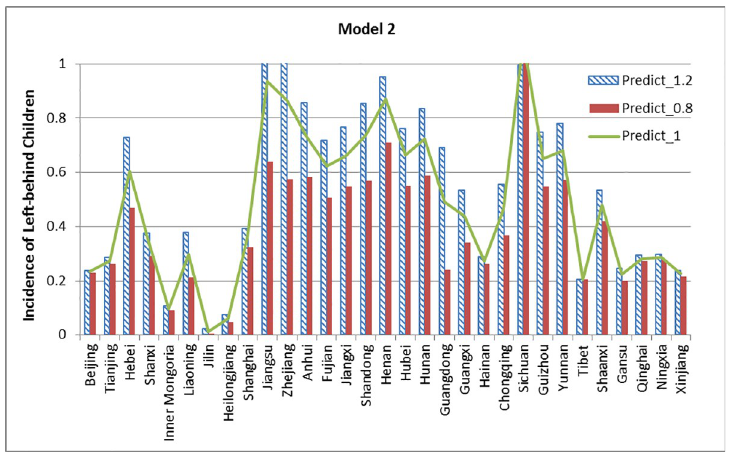
Fig 21. Simulation results of Model